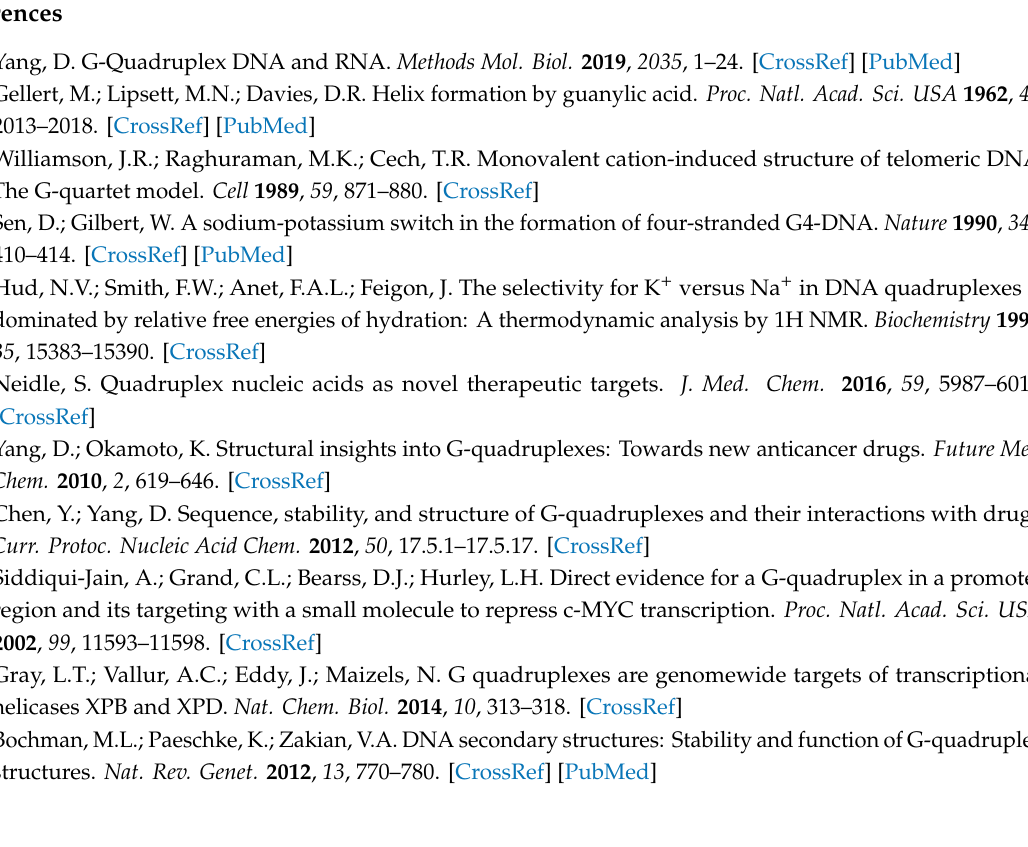
Supplementary Materials: The following are available online. Figure S1: Comparison of replicate fluorescence intensity of Cy5-PDS in the absence and presence of 1, 3, and 10 µ M of BMVC; Figure S2: Competition microarray experiments of Cy5-PDS with unlabeled PDS; Figure S3: NMR solution structure of the 2:1 complex of BMVC and MYC_14 / 23T G4 (PDB ID: 6O2L); Figure S4: Apparent dissociation constant (Kd, app) of BMVC binding to various G4s; Figure S5: 1D 1H NMR titration spectra of BMVC with various G4 sequences; Figure S6: 1D 1H NMR titration spectra of BMVC with MYC_14 / 23T flanking